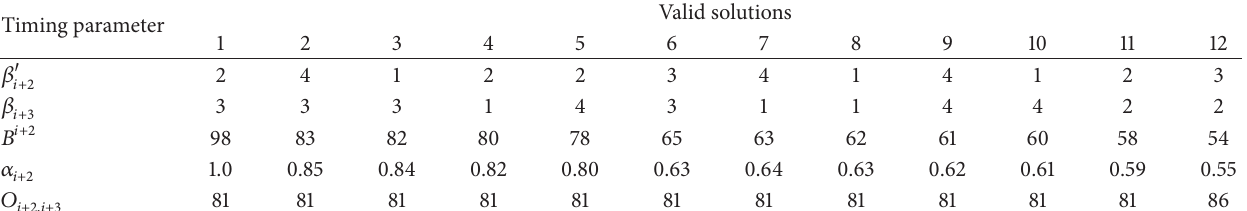
Table 6: Optimized results for 𝐿 𝑖+2,𝑖+3 on Kietzke Lane ( 𝐺